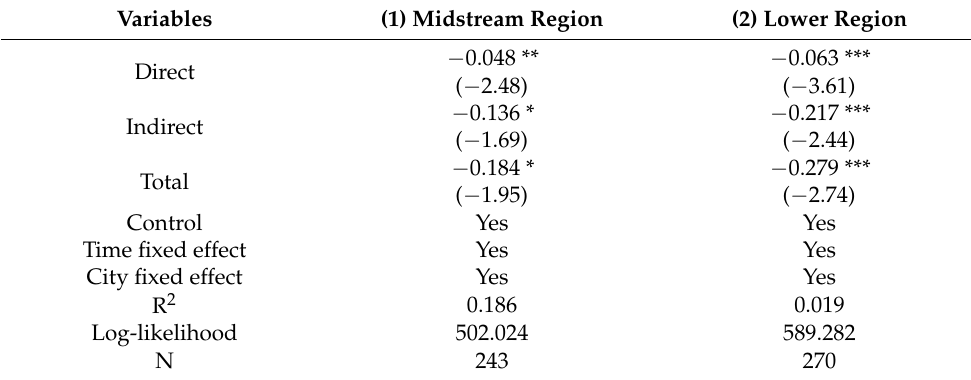
Table 8. The results of heterogeneity analysis.